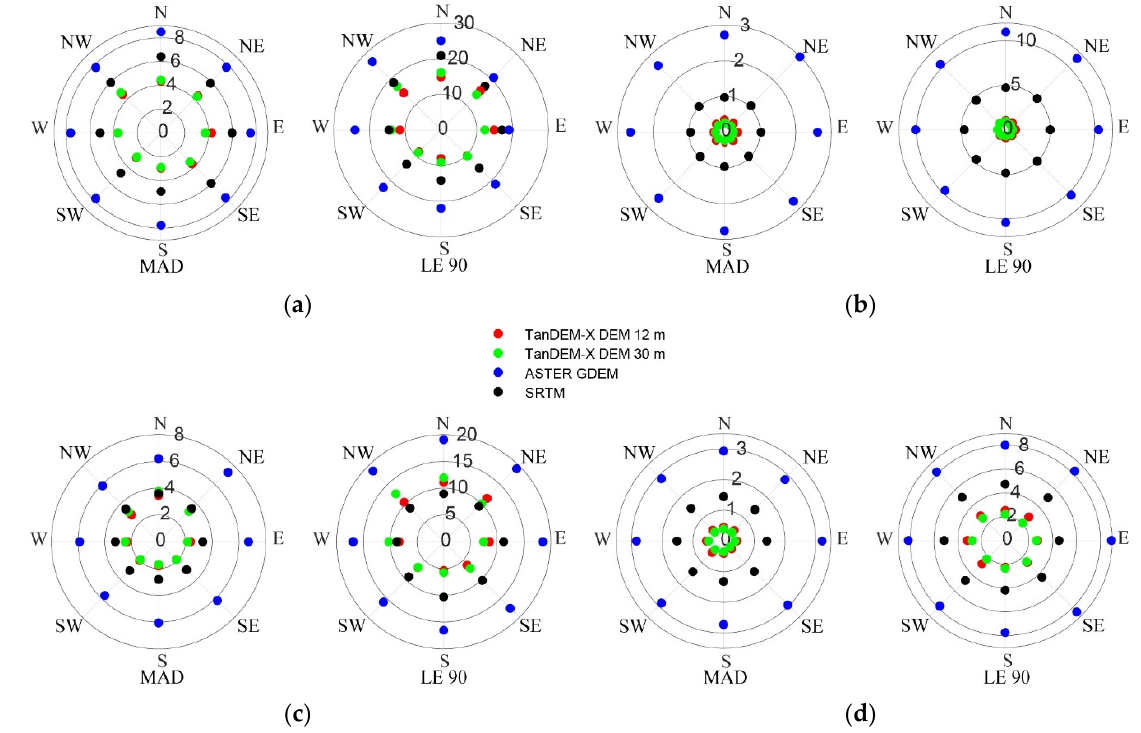
Figure 8. The relationship between quality indicators ((left) MAD and (right) LE90) and aspects in four study areas: ( a ) Sichuan; ( b ) Xinjiang A; ( c ) Xinjiang B; and ( d ) Inner Mongolia.